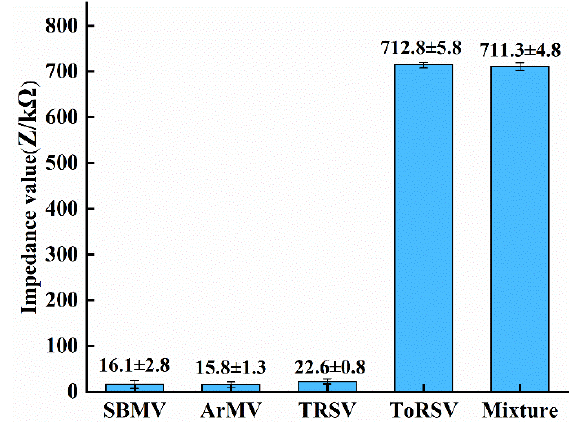
Figure 8. Impedance values of different viruses.